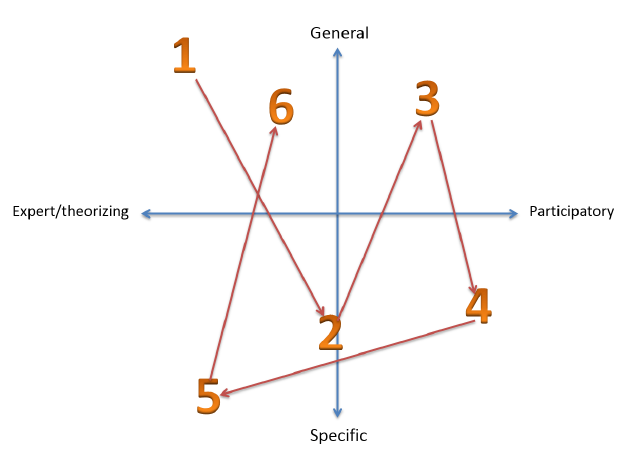
Fig. 5 . Moore’s research